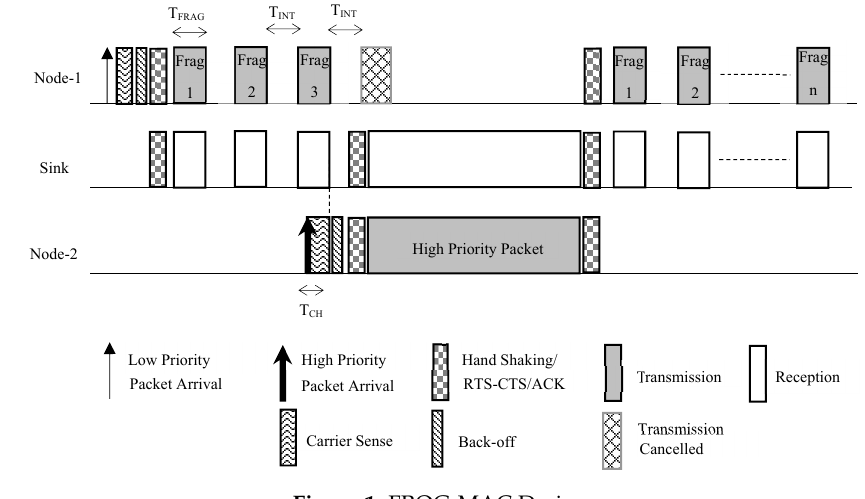
Figure 1. FROG-MAC Design.